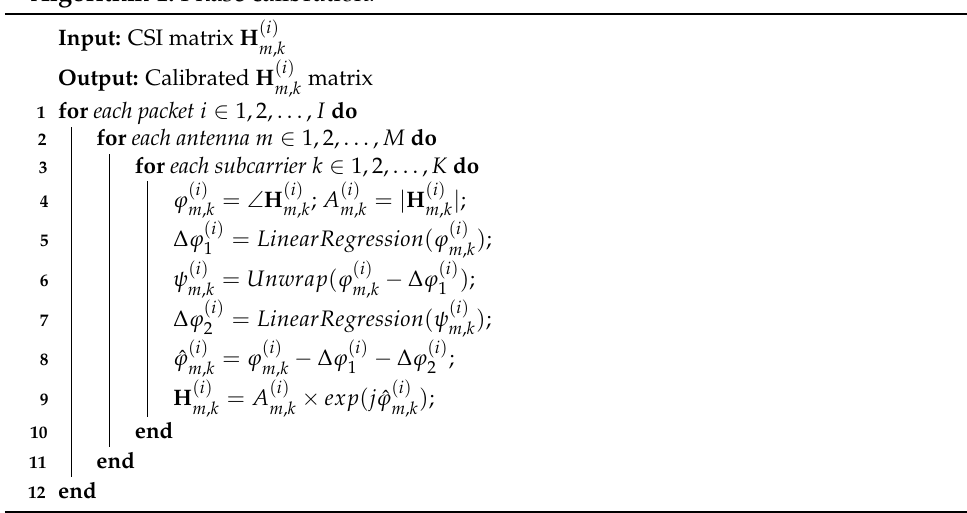
Algorithm 1: Phase